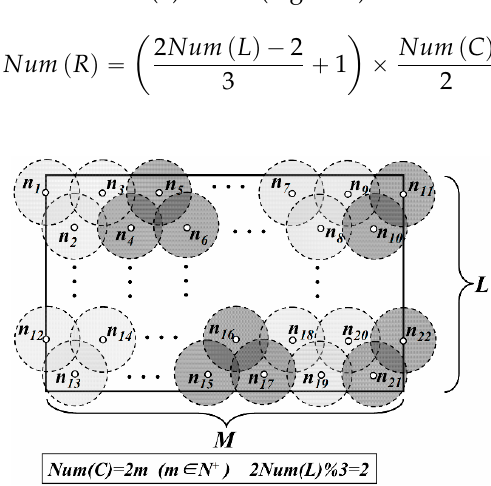
Figure 4. Distribution of DGAs ( Case 3 ).